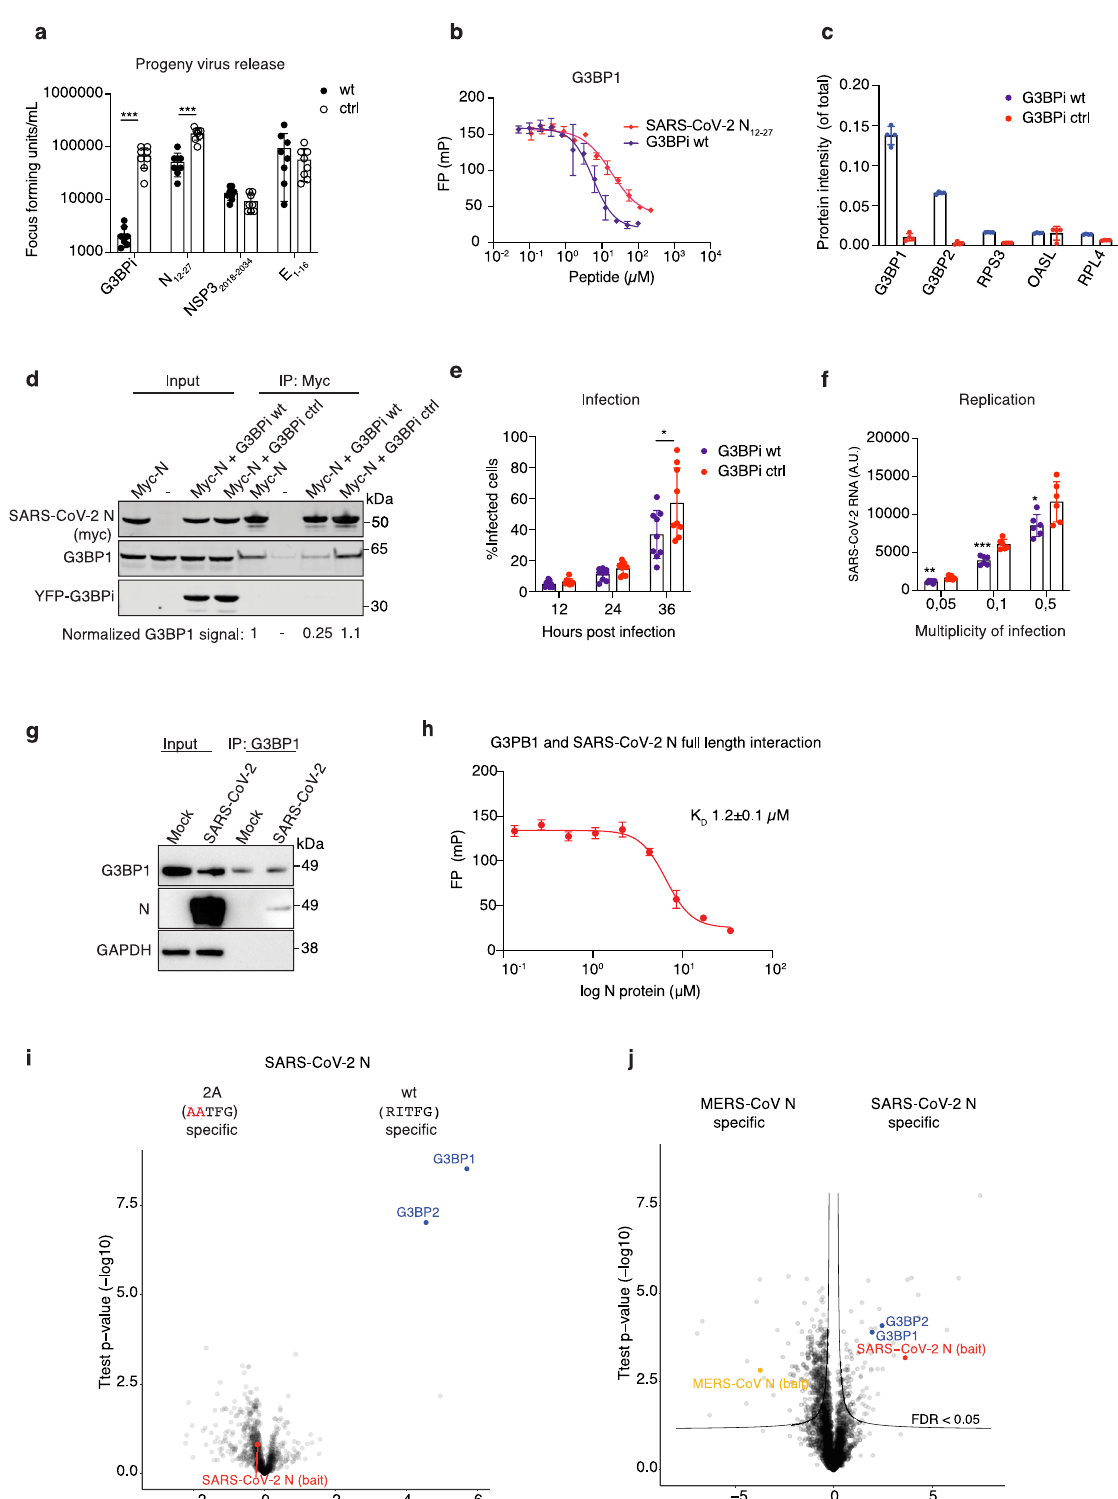
amino acid residue peptide from Semliki Forest virus (SFV) nsP3 containing two continuous FGDF like SLiMs that has previously been shown to bind G3PBs with high af fi nity 31 . Remarkably, this peptide binds approximately 10-fold stronger than the SARS- CoV-2 N peptide to both G3BP1 and G3BP2 (K D = 4 μ M vs K D = 0.3 μ M, Fig. 2b and Supplementary Fig. 3a). We constructed “ G3BP inhibitors ” (G3BPi) by fusing sequences encoding one or